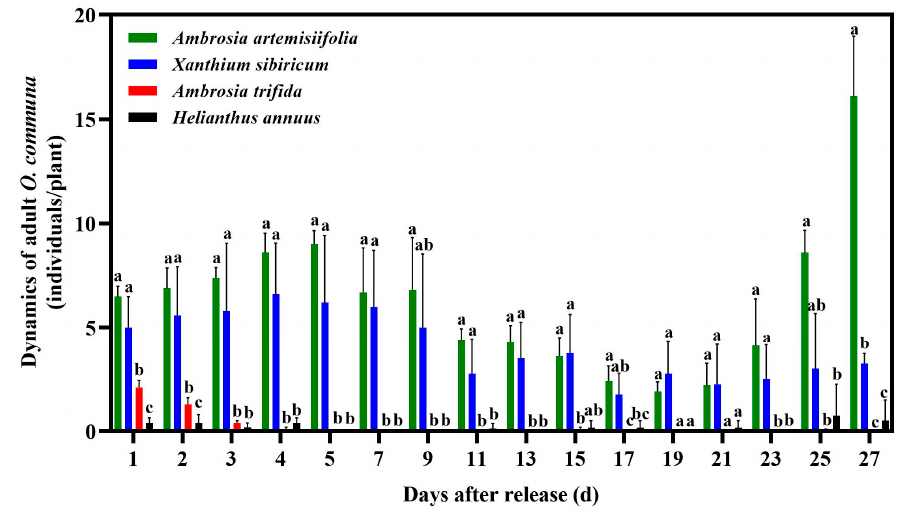
Figure 3. Dynamics of adult Ophraella communa occurrence on four coexisting plant species in cage experiments. All values are shown as the means ± SE. Values with the same letter in the same day are not significantly different (three-way ANOVA followed by Tukey test at p ≤ 0.05).